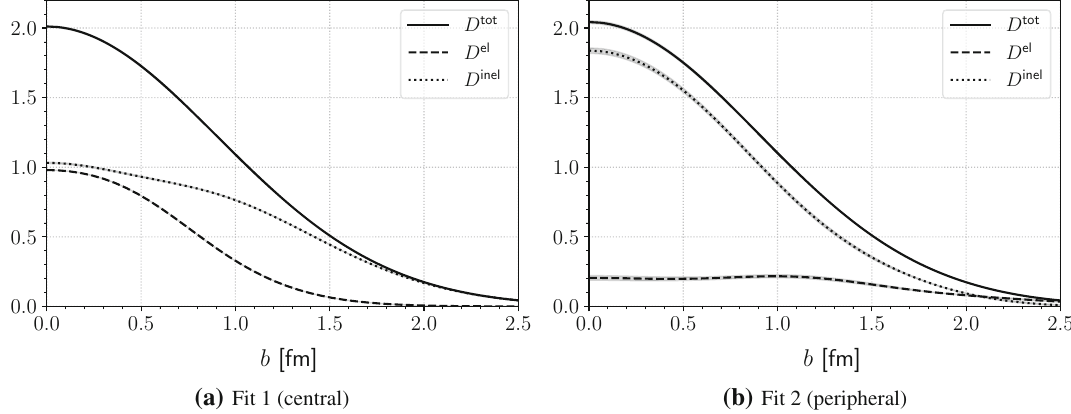
Fig. 11 Proton-proton profile functions D ( b ) at energy of 8 TeV corresponding to Fits 1 and 2 and determined on the basis of Eqs. (38), (35) and (44). Full line corresponds to total profile function, dashed line to elastic one and dotted line to inelastic one